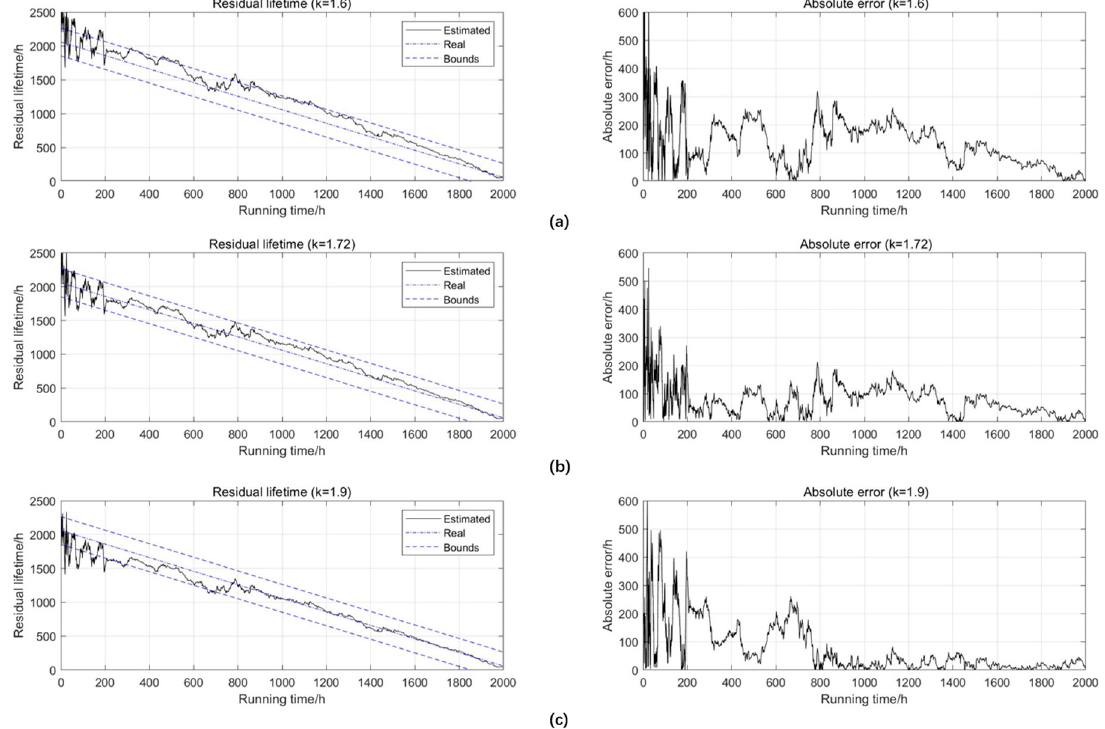
= 1.6; ( b ) k = 1.72; ( c ) k =